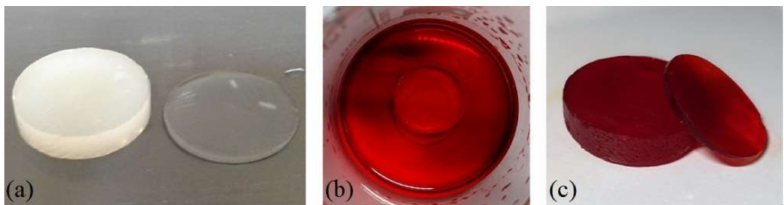
Figure 8. Demonstration of the possibility of sorption of organic dye by pHEMA-gr-PVP copolymer: ( a ) copolymer swollen in water; ( b ) the process of swelling of pHEMA-gr-PVP copolymer in dye solution; ( c ) pHEMA-gr-PVP copolymer with adsorbed dye.